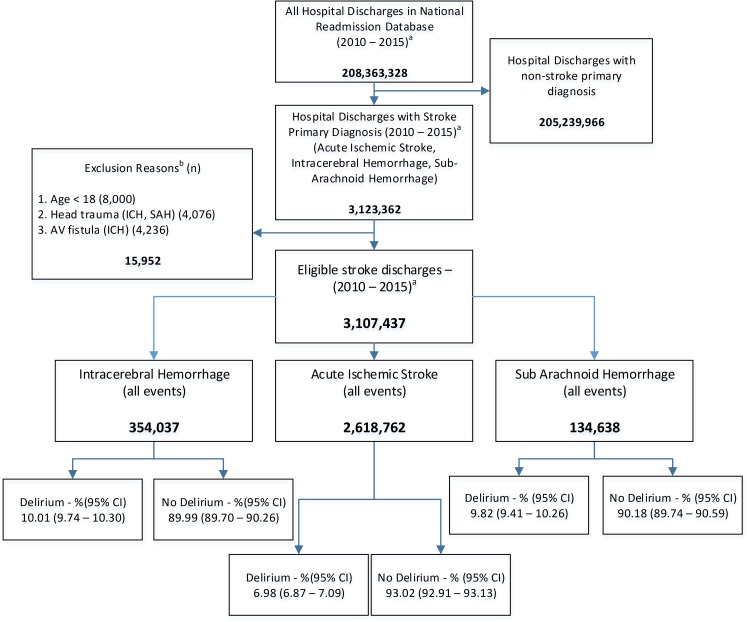
Eligible stroke discharges, reasons for exclusion, and proportion (95% confidence intervals) of stroke patient discharges with and without delirium between January 1, 2010 and September 30, 2015 in the National Readmission Database.Proportions and 95% confidence intervals for initial, excluded, eligible, and analyzed population of ischemic and hemorrhagic stroke patients along with proportion and 95% confidence interval for frequency of delirium observed for different stroke subtypes for the entire duration of analyses (2010–2015). The listed reasons for non-inclusion are not mutually exclusive.